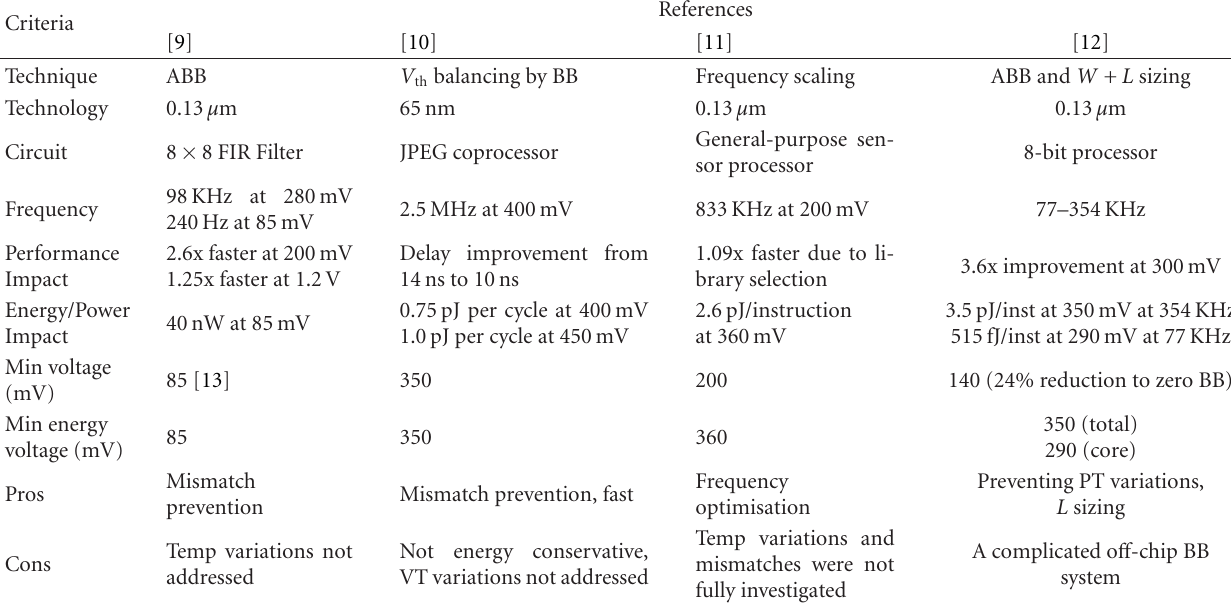
Table 1: Comparison of e ff ect of di ff erent techniques for further power-performance improvements.